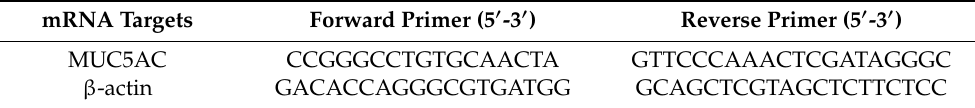
Table 3. Primer sequences of the targets MUC5AC and β -actin for RT-PCR. mRNA